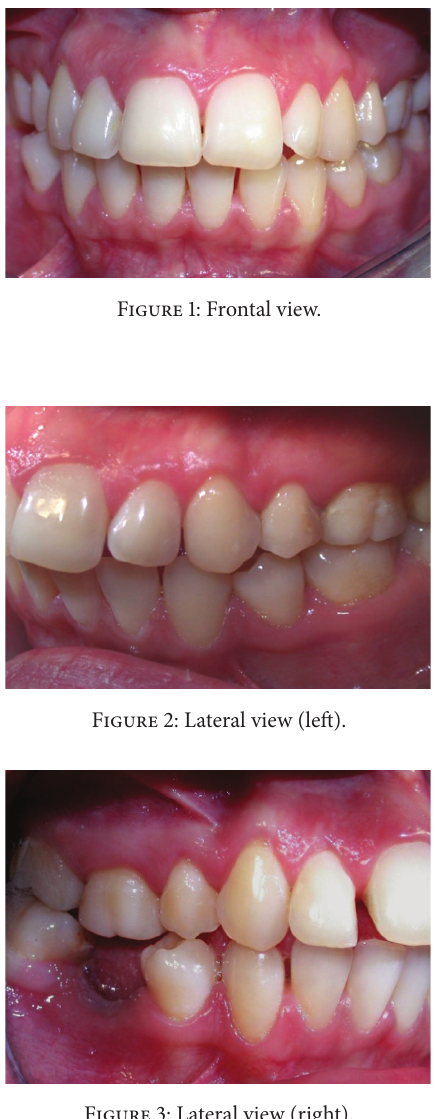
Figure 3: Lateral view (right).